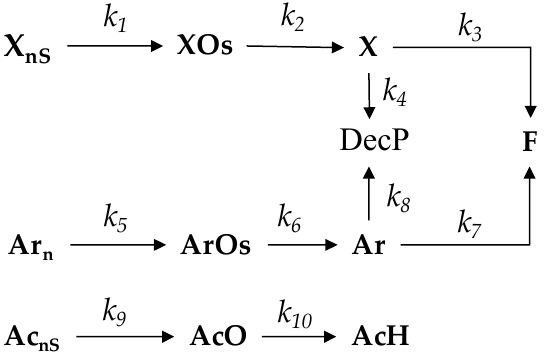
Figure 2. Kinetic model considered in this study. Table 5. Equations employed for kinetic modeling of the reactions involving hemicellulosic polysaccharides and acetyl groups in wood.